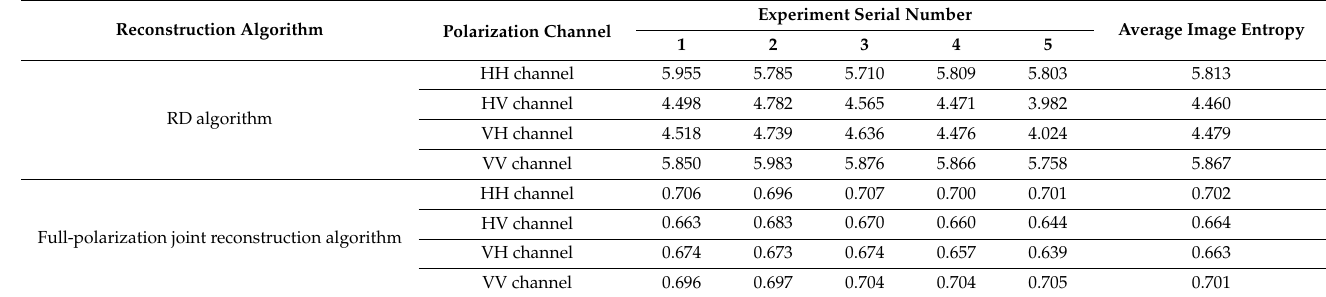
Table 2. ISAR reconstructed image